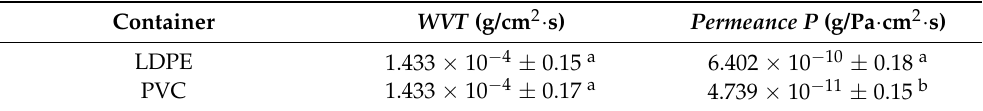
Table 1. Water vapor transmission rate (WVT) and permeance (P) of